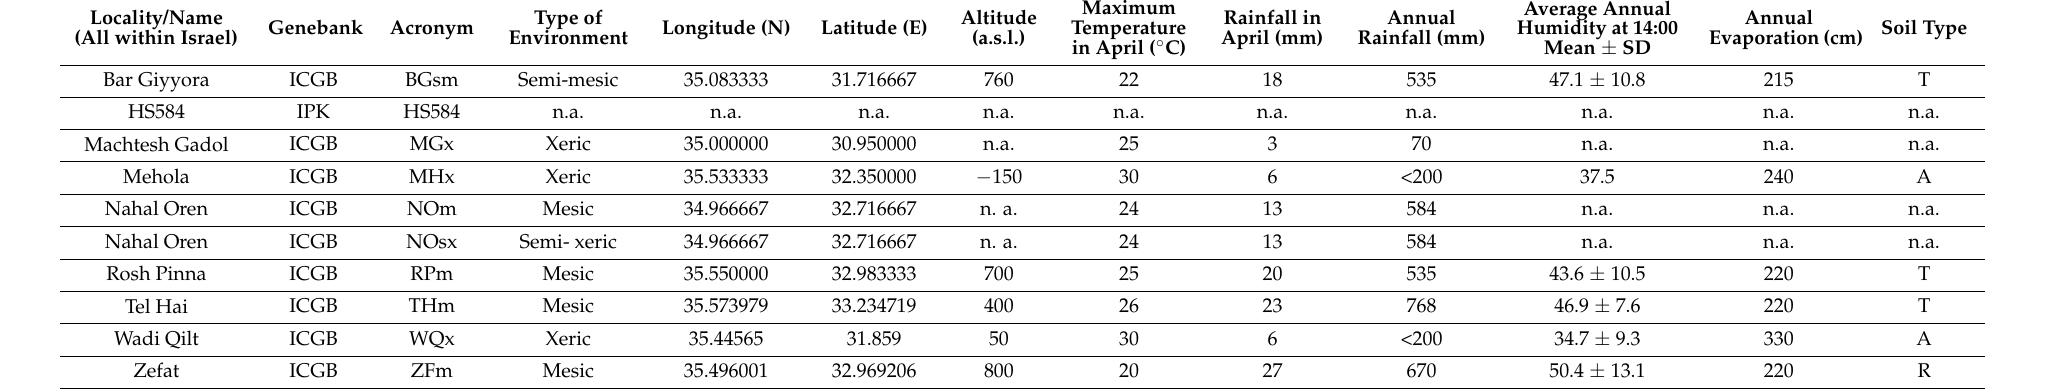
Table 1. Sampling sites and ecogeographical data of the analyzed wild barley